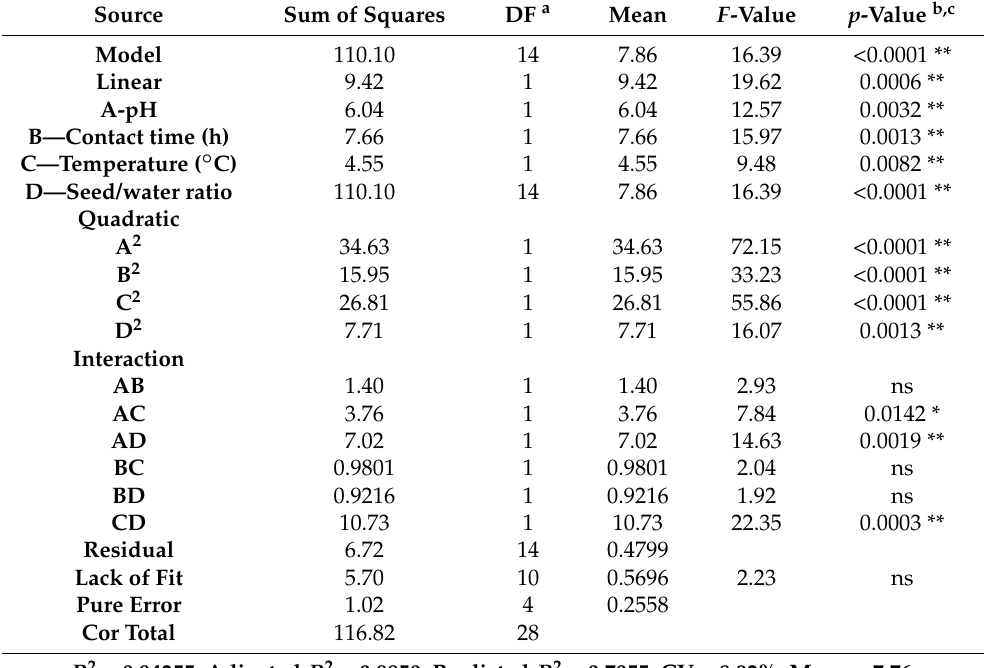
Table 3. ANOVA of the experimental results of the